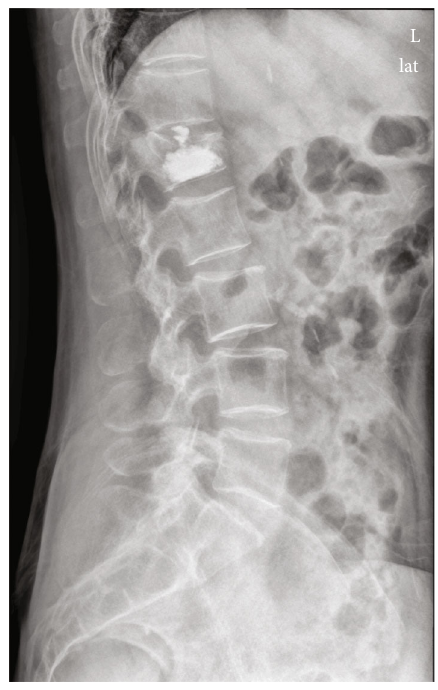
Figure 1: Cement leakage into the intervertebral disc on direct postoperative